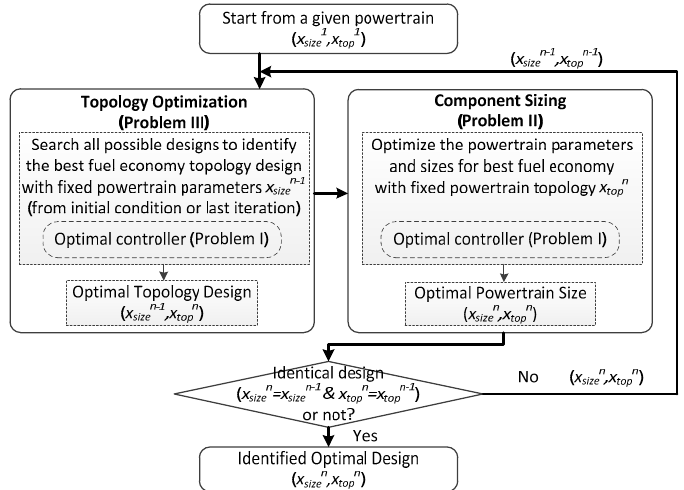
Figure 7. Flow chart of the iterative optimization.